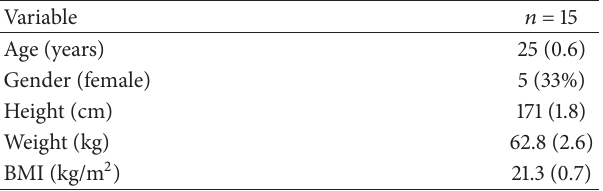
Table 1: Demographic data in all